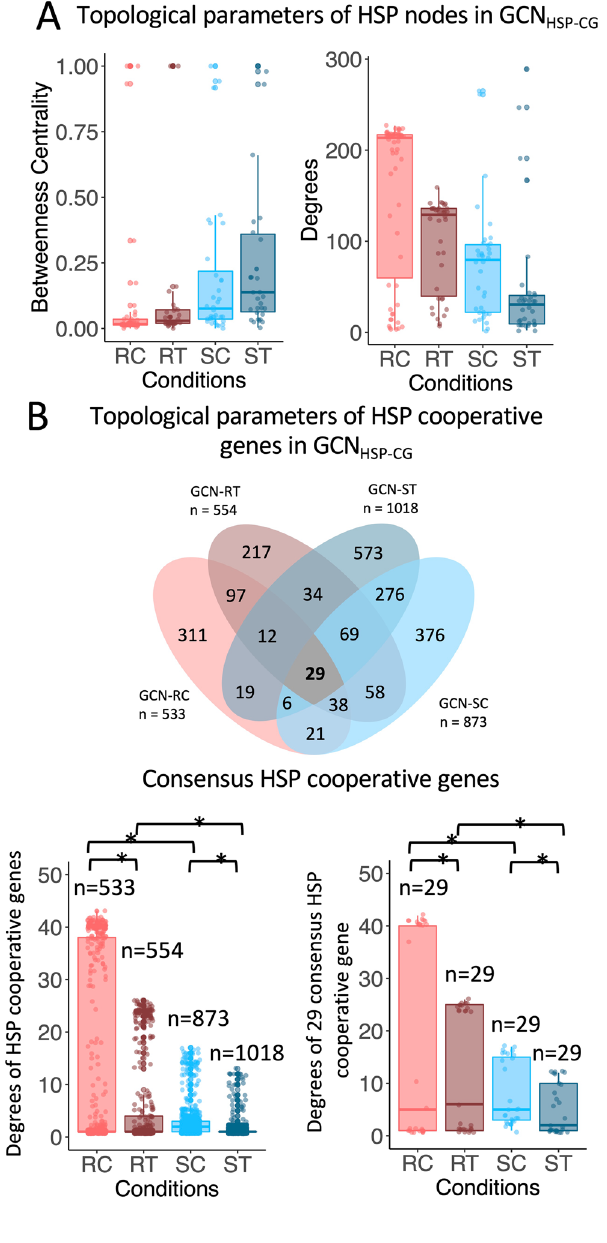
Figure 5. Topological analysis of HSP gene co-expression networks. ( A ) Boxplot showing the distribution of topological parameters, betweenness centrality and node degree distribution, of HSP genes in GCN HSP-CG . GCN-RC had the lowest betweenness centrality and highest node degree, indicating that HSPs are highly cooperative and can alternatively be used for defense purposes. ( B ) Boxplot showing node degree distribution of HSP-cooperative genes: (B-top) HSP-cooperative genes in the four conditions, (B-bottom-left) node degree distribution of HSP-cooperative genes in GCN HSP-CG (n RC = 533 genes, n RT = 554 genes, n SC = 873 genes, n ST = 1018 genes), (B-bottom-right) node degree distribution of HSP cooperative genes present in all four conditions of GCN HSP-CG (n = 29 genes). Asterisks (*) indicate statistical differences based on the Wilcoxon rank-sum one-tailed test ( p -value < 0.05). It was evident that GCN-RC > GCN-RT, GCN-SC > GCN-ST, GCN-RC > GCN-SC and GCN-RT >